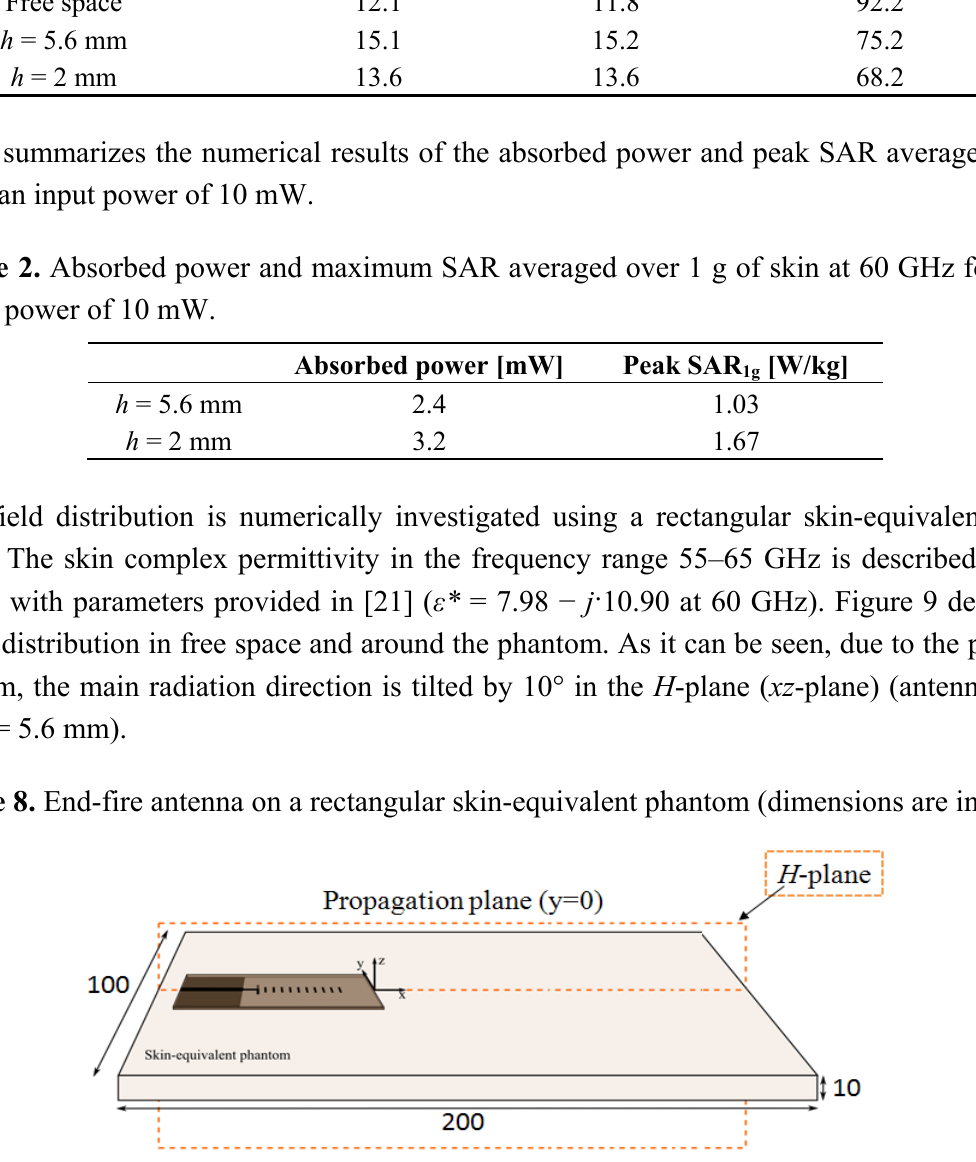
Table 1. Antenna gain and radiation efficiency for different antenna/phantom distances. Antenna position